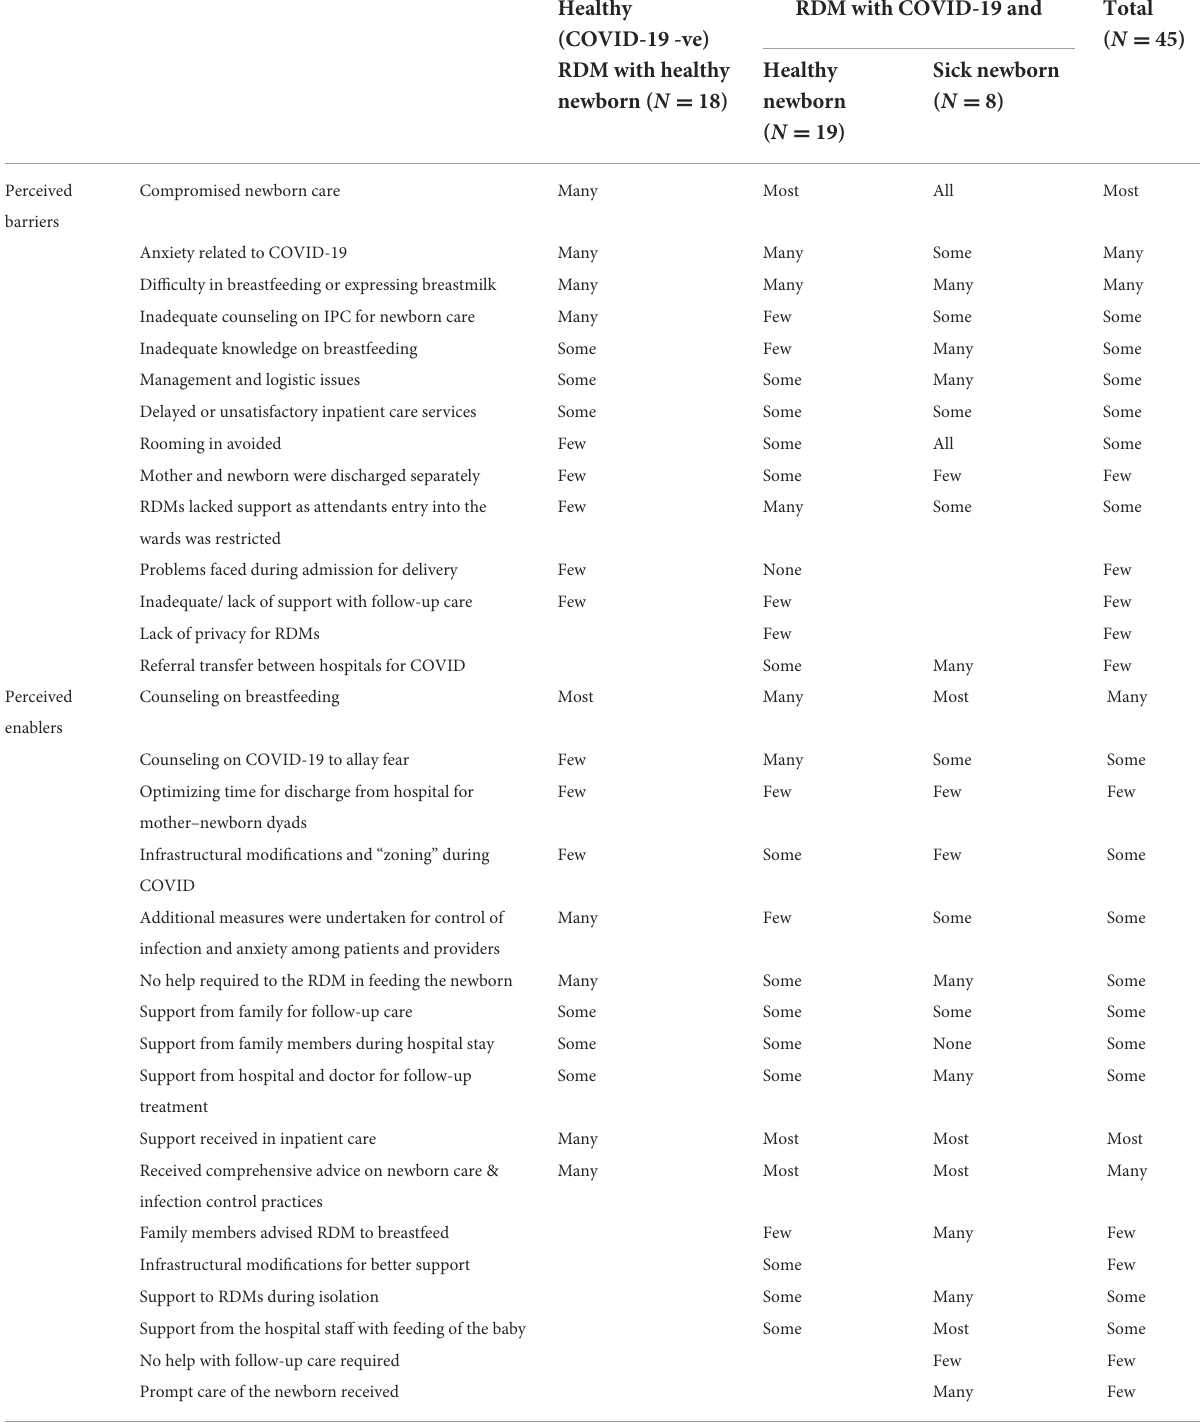
TABLE 2 List of core themes and sub-themes for optimal breastfeeding practices emerging from inductive data analysis and their code prevalence according to the different groups of recently delivered mothers. Core